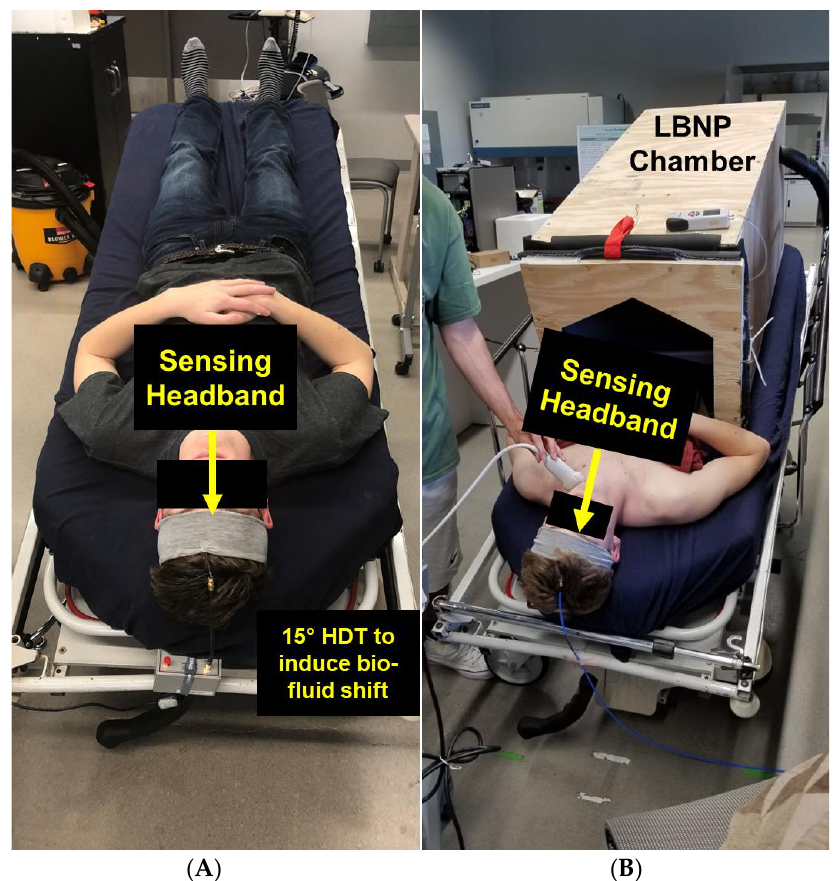
Figure 2. EM skin patch sensor embedded in wearable headband to detect induced bio-fluid shift in (A) 15° head down tilt and B) during administration of lower body negative pressure (LBNP). ( A ) 15 ◦ head down tilt and ( B ) during administration of lower body negative pressure